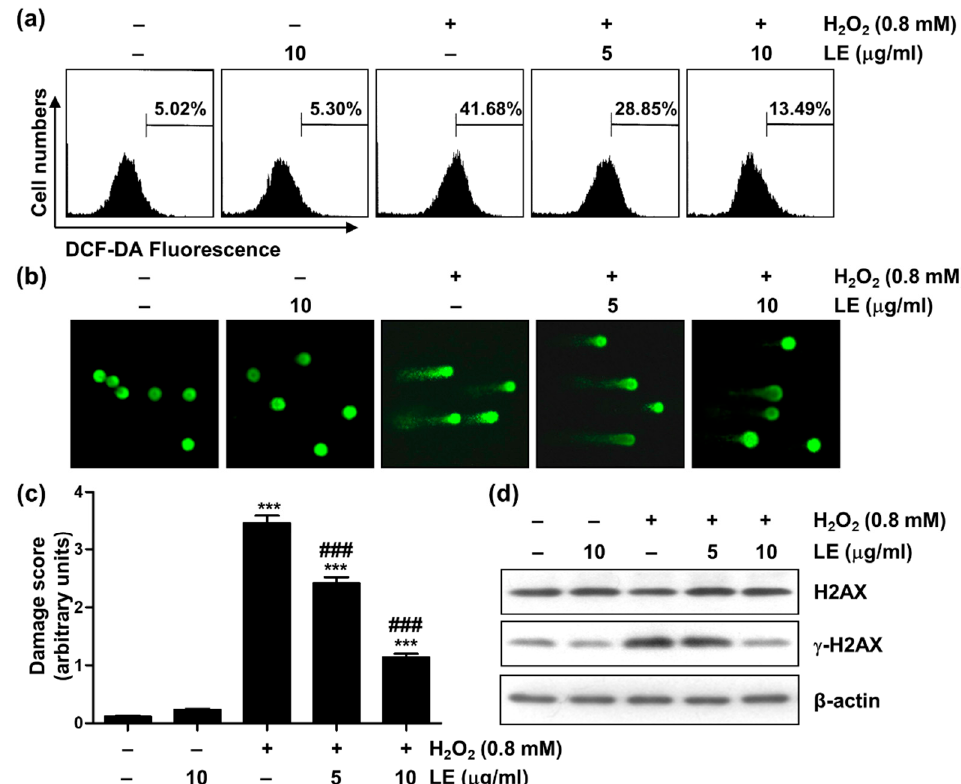
Figure 2. Effect of LE on H 2 O 2 -induced ROS generation and DNA damage in C2C12 cells. Cells were pretreated with LE for 1 h and treated, with or without 0.8 mM H 2 O 2 , for 1 h ( a ) or 24 h ( b ), ( c ), and ( d ). ( a ) Intracellular ROS levels were measured using 2 ′ ,7 ′ -dichlorofluorescein diacetate (DCF-DA) staining and flow cytometry. Representative results of three independent experiments are shown; ( b ) DNA damage was evaluated using a comet assay. DNA damage is observed in the comet’s tail, while intact DNA remains in the comet’s head. Representative results of three independent experi- ments are shown; ( c ) DNA damage score. Data indicate mean ± SD values ( n = 3; *** p < 0.001 vs. control cells; ### p < 0.001 vs. H 2 O 2 -treated cells); ( d ) H2AX and γ -H2AX levels analysis of cell lysates. Western blot analysis was performed using β -actin as a loading control. Representative results of three independent experiments are shown. H2AX, H2A histone family member X.